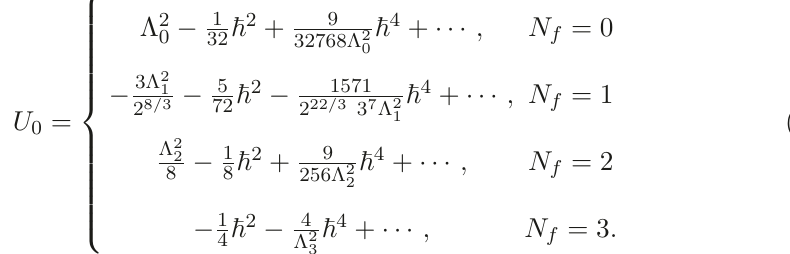
for N f = 3, where the first several coefficients and the table